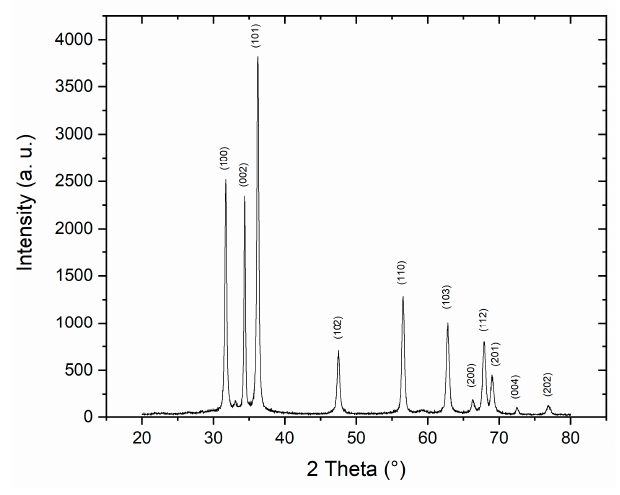
Figure 5. XRD spectrum of ZnO NPs.